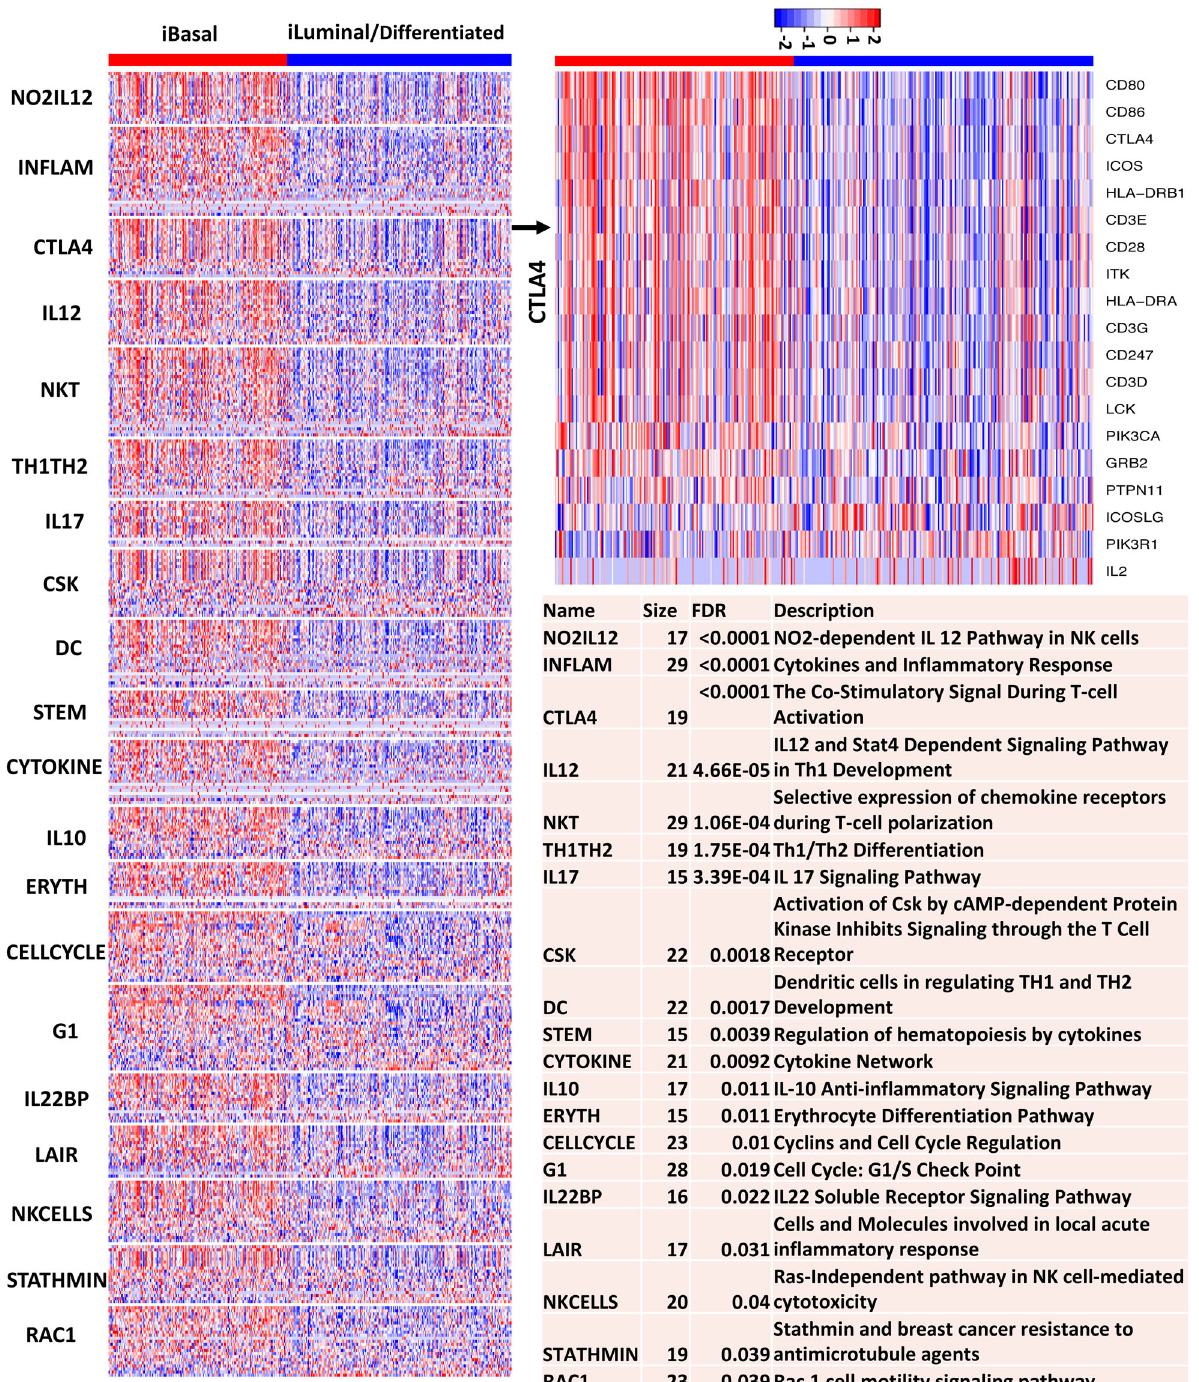
Fig. 6 Top up-regulated BIOCARTA pathways in the basal subtype of the TCGA MIBC samples. On the heatmap, red and blue represent high and low expression, respectively. Gene-based permutation test was used to calculate the